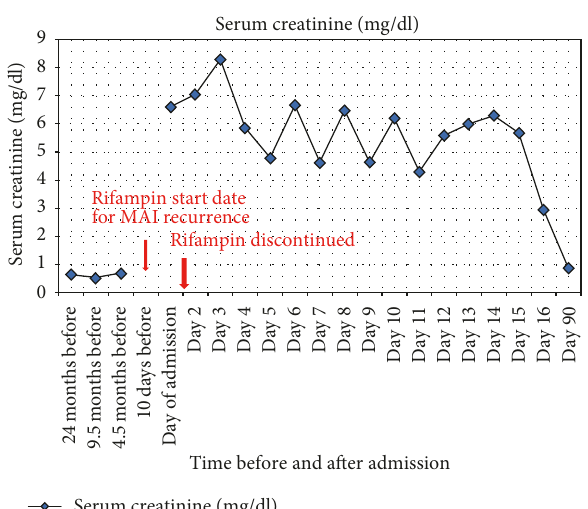
Figure 1: Graph with patient’s serum creatinine over time, before and after admission for AKI.